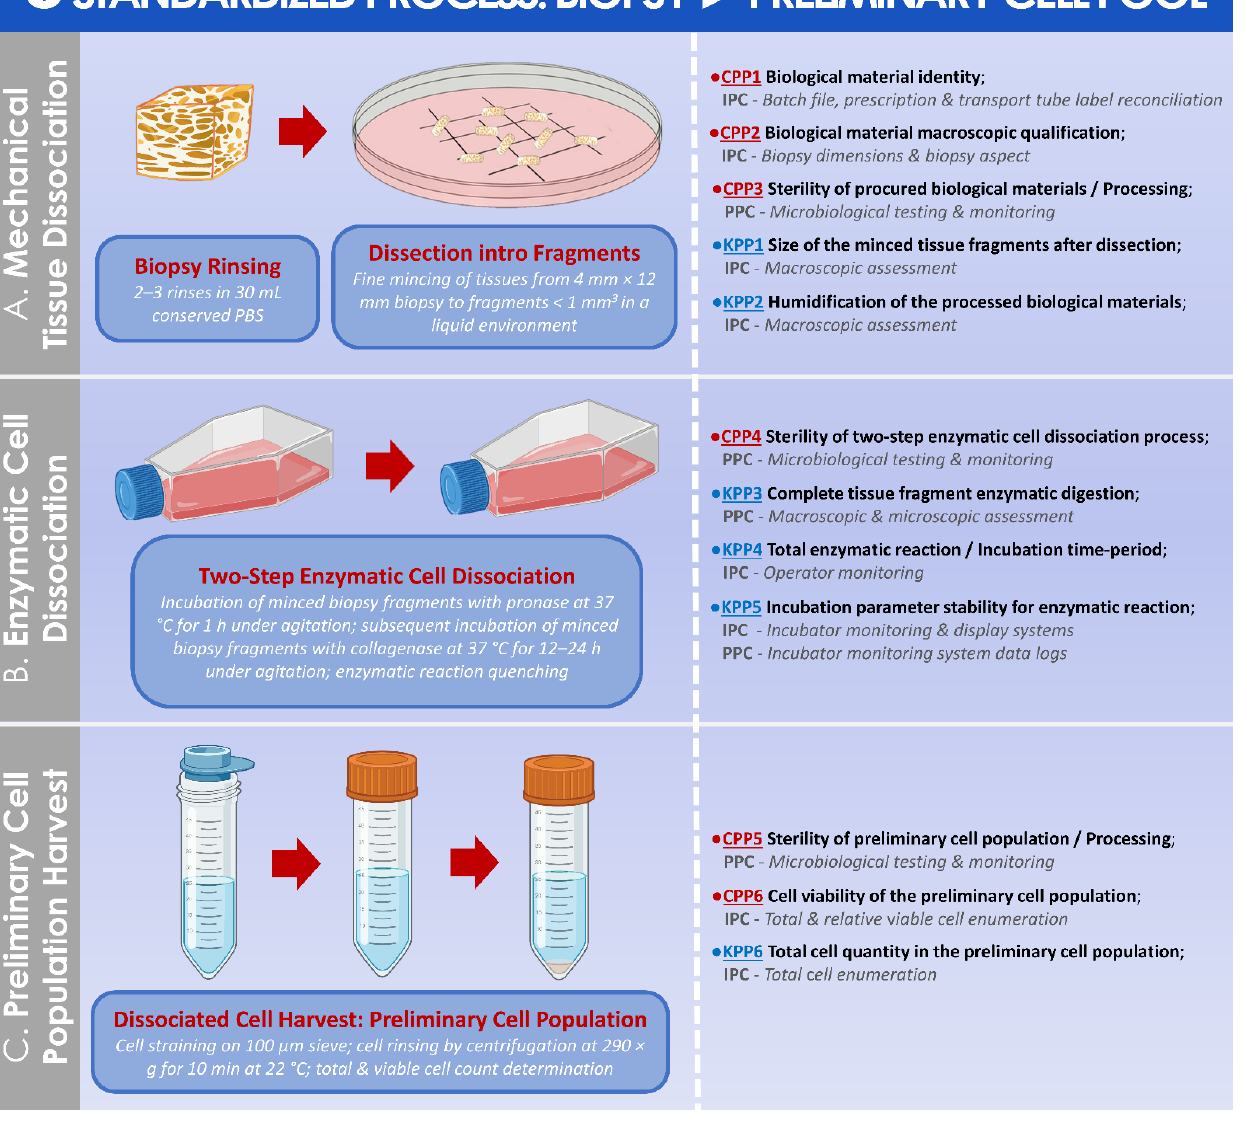
Figure 7. Standardized parametric and controlled process overview for the obtention of the preliminary HAC cell population from the cartilage tissue biopsy. ( A ) Mechanical cartilage tissue dissociation process, in preparation for the enzymatic tissue treatment. ( B ) Two-step enzymatic cartilage tissue treatment for in vitro HAC cell dissociation. ( C ) In vitro isolation of the prelimi- nary HAC cell population. The established CPPs, KPPs, IPCs, and PPCs are further defined in the supplementary document–Process Parameters: Table SPP1. API, active pharmaceutical ingredient; CPP, critical process parameter; HAC, human articular chondrocytes; IPC, in-process control; KPP, key process parameter; PBS, phosphate-buffered saline; PPC, post-process